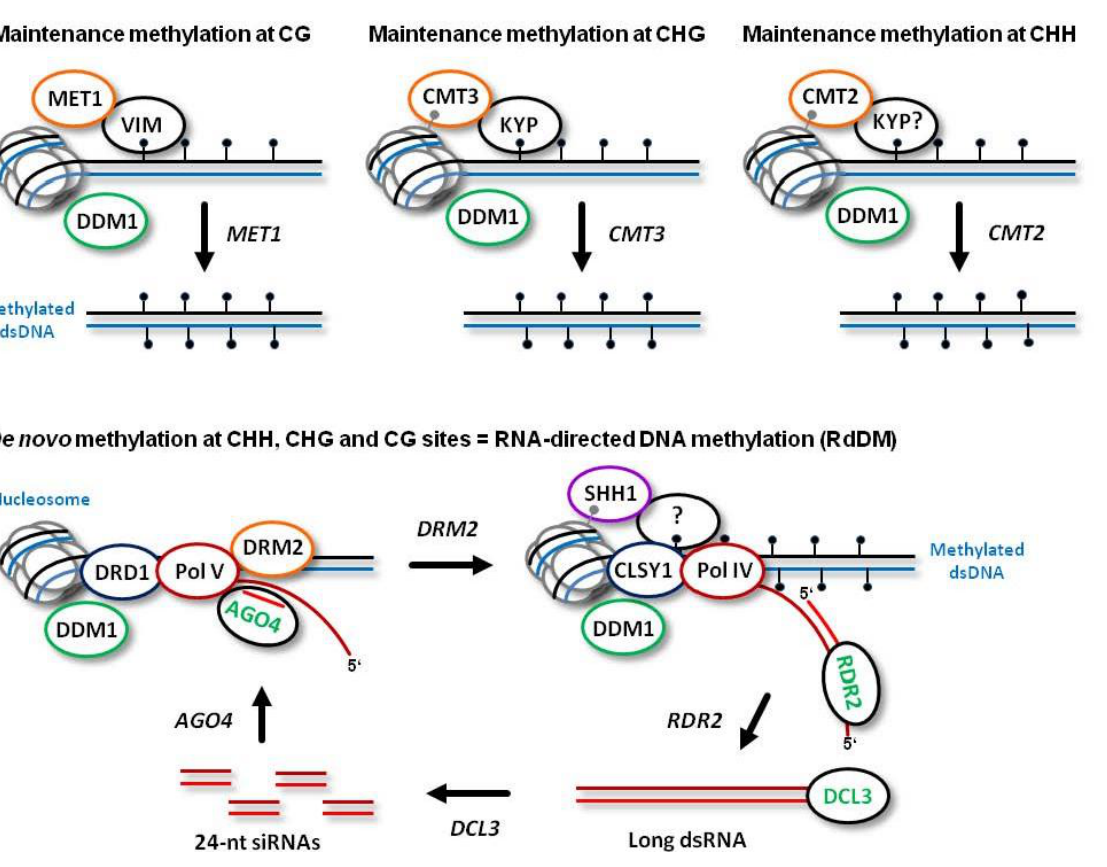
Figure 1. Models for maintenance methylation and RdDM at the plant genome loci. (Based mostly on the findings using the model plant Arabidopsis ). The plant dsDNA associated with nucleosomes is depicted as solid lines and the methylated cytosines at one or both strands indicated with black lollypops. Following DNA replication, cytosine methylation at CG, CHG and CHH sites of the newly-synthesized strand (blue) is catalyzed by the maintenance methyltransferates MET1, CMT3, and CMT2, respectively, with the help of co-factors VIM and KYP that recognize hemimethylated dsDNA; CMT3 and CMT2 also bind the repressive histone methylation mark H3K9me2 indicated as grey lollypops. The RNA-directed DNA methylation (RdDM) pathway establishing methylation of dsDNA de novo is catalyzed by DRM2 that interacts with the DRD1-Pol V complex generating a scaffold transcript. The nascent scaffold transcript is targeted by the 24-nt siRNA-AGO4 complex. Following DRM2-catalyzed de novo methylation of both DNA strands, Pol IV with the help of SHH1 (binding H3K9me2) and CLSY1 initiates siRNA biogenesis. The Pol IV transcript is converted by RDR2 to dsRNA. The resulting dsRNA is processed by DCL3 into 24-nt siRNA duplexes. The duplexes are handed over to AGO4 to form the silencing complexes with a single-stranded siRNA guide. This completes an siRNA amplification loop that reinforces RdDM-mediated transcriptional silencing. The